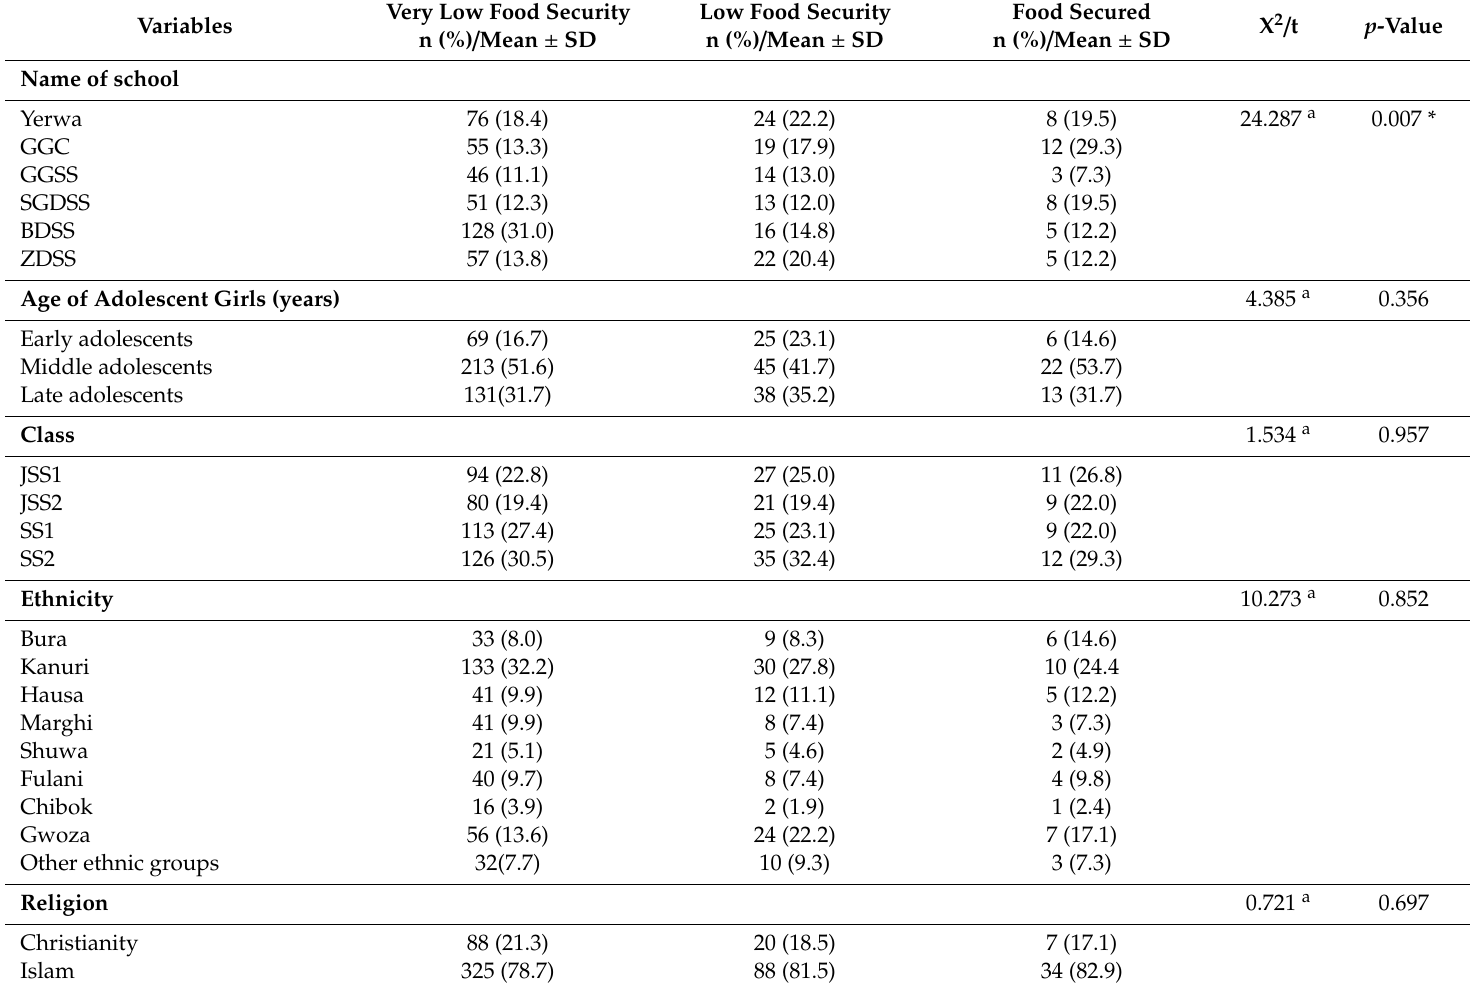
Table 3. Factors associated with food security among respondents (n =